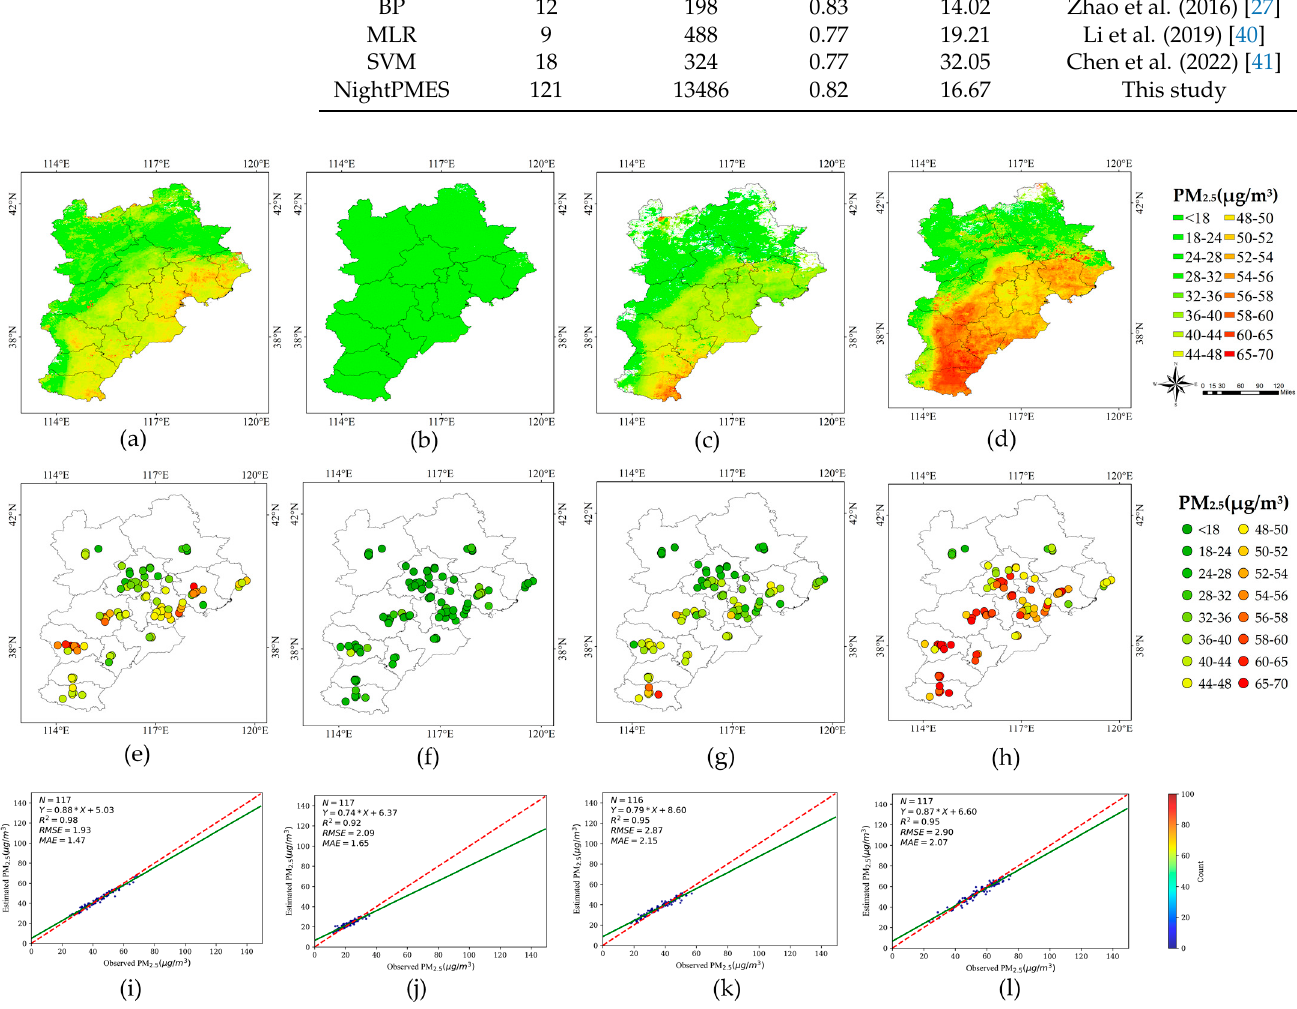
Figure 6. Spatial distributions for spring (March, April, and May), summer (June, July, and August), autumn (September, October, and November), and winter (December, January, and February) mean PM 2.5 concentrations. ( a – d ) NightPMES model estimates; ( e – h ) ground observations; ( i – l ) scatterplots of the ground observations versus the NightPMES model estimates.